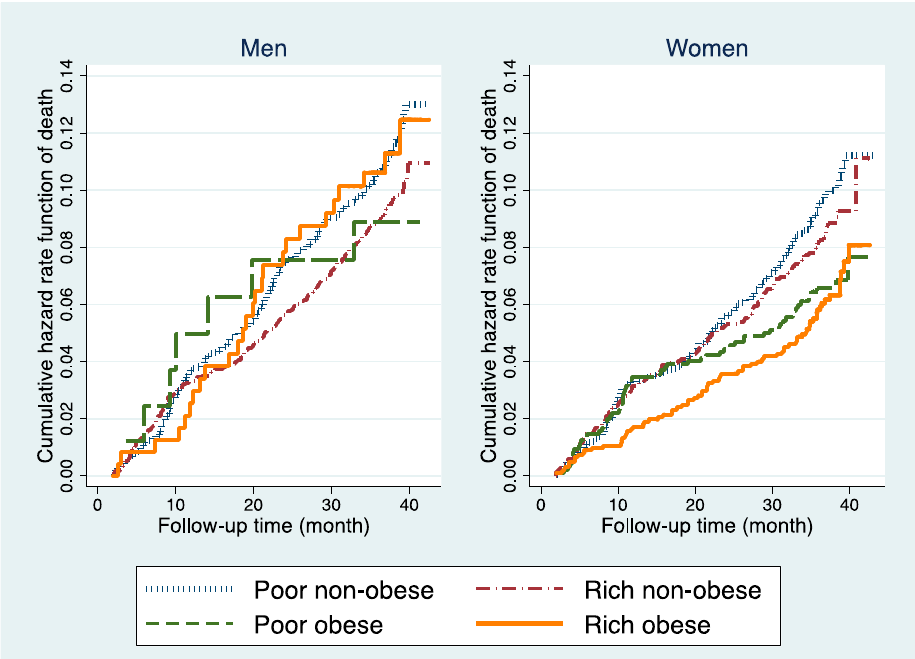
Figure 2. Nelson-Aalen cumulative hazard curve in men and women, stratified by wealth and abdominal obesity status during the study period (2007–2010). WHO-INDEPTH SAGE Purworejo longitudinal data. Table 2. All-cause mortality stratified by sex and wealth status. Hazard ratio (HR) and 95% confidence intervals (CI) from multivariate adjusted Cox regression analysis with restricted cubic splines of waist circumference at 5th, 25th, 75th and 95th percentiles. WHO-INDEPTH SAGE Purworejo longitudinal data (2007–2010).